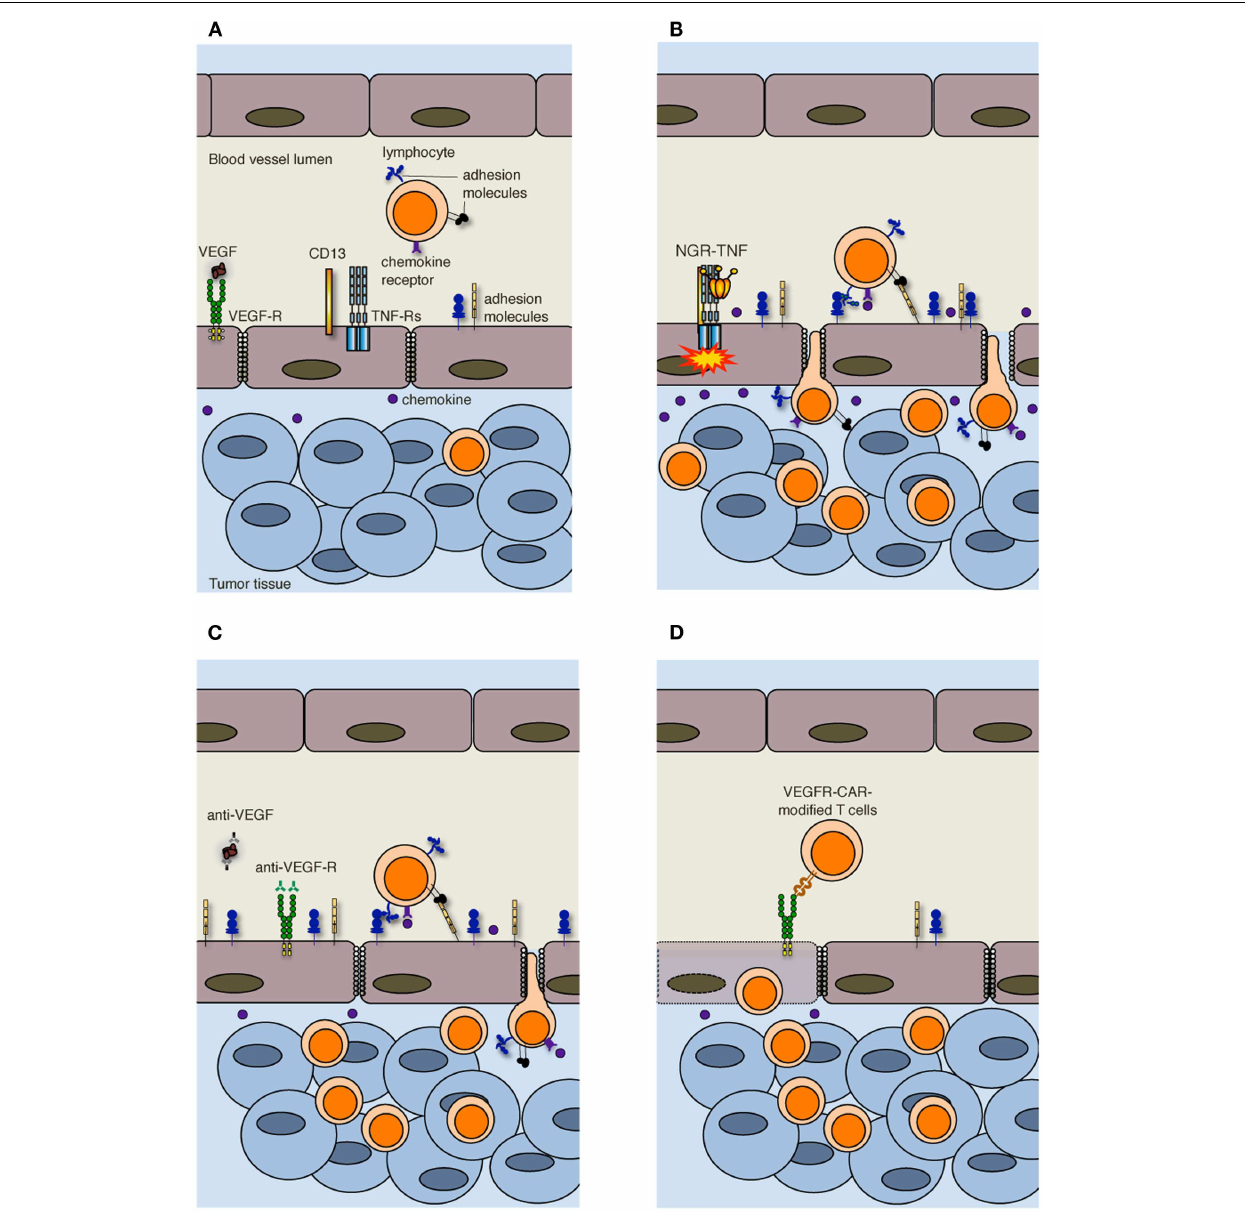
favoring the recruitment and extravasation ofT lymphocytes. (C) Anti-VEGF and anti-VEGF-R antibodies both transiently normalize the tumor-vasculature and overcome EC anergy, thus favoringT cell trafficking within tumors. (D) Also immunization againstVEGF-R2 or the adoptive transfer of autologousT cells genetically engineered to express chimeric antigen receptor targeted againstVEGF-R2 (VEGFR-CAR) favor tumor infiltration byT cells, although the mechanism has not yet been clarified. It has been proposed thatVEGF-R-specificT cells kill both ECs and MDSCs andTregs (not shown) that